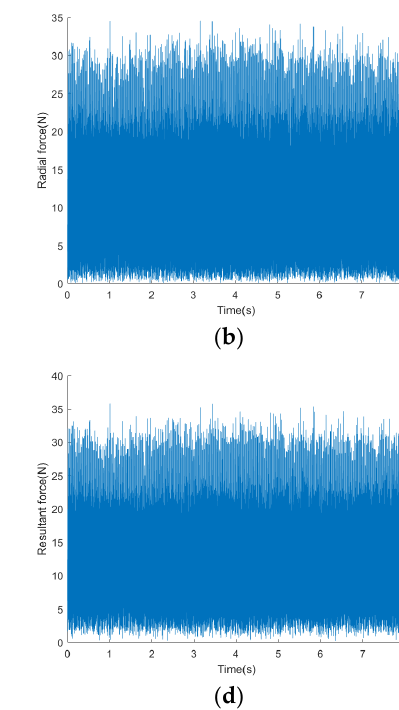
Figure 23. Cutting force: ( a ) radial force of DACT; ( b ) radial force of BEM; ( c ) resultant force of DACT; ( d ) resultant force of BEM.